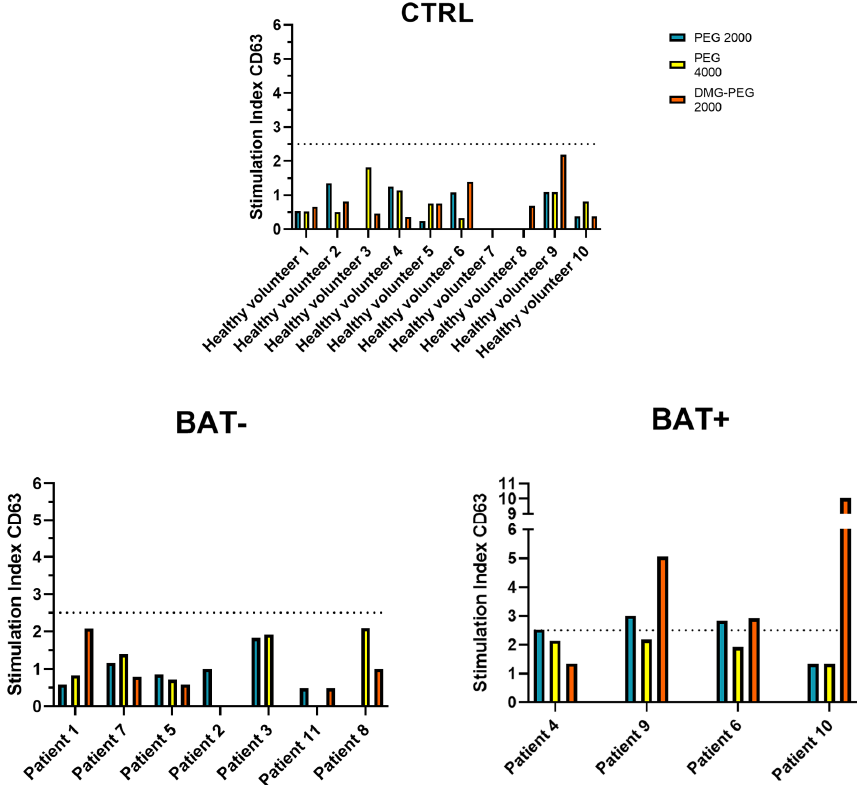
Figure 2. Stimulation index (SI) of CD63 expression. The graphs show the SI of the control group, patients that were negative for the test (BAT − ), and patients that were considered positive (BAT+). SI > 2.5 was considered as positivity for the test.